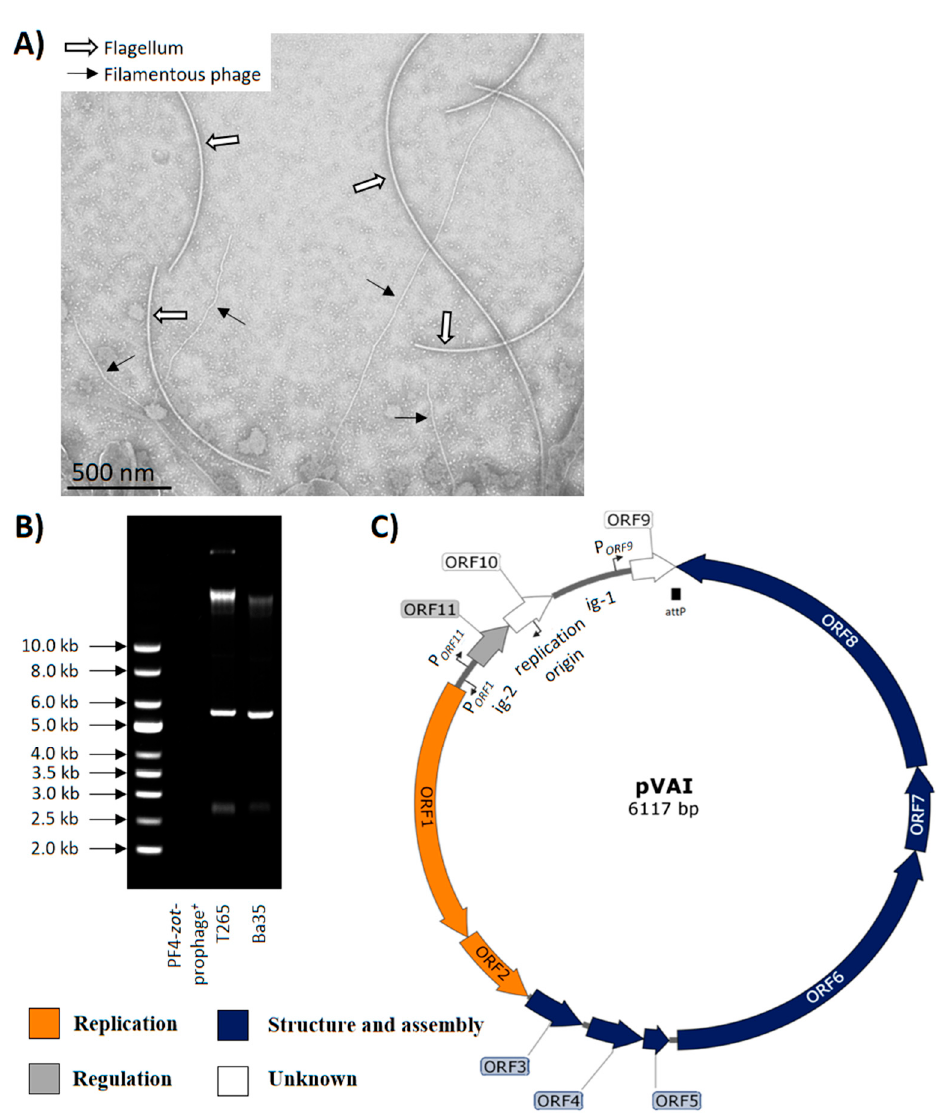
Figure 1. Electron micrograph of VAI ϕ particles and schematic representation of pVAIs. ( A ) Transmission electron micrographs of overnight cultures of Vibrio anguillarum strain Ba35. ( B ) Extraction of replicative forms in V. anguillarum strains separated on a 0.8% agarose gel. A supercoiled DNA ladder is shown to the left. ( C ) Schematic representation of pVAIs, the predicted attP , replication origin, promoters, intergenic regions and ORF organization. ORFs are represented by arrows oriented in the direction of transcription. The colors were assigned according to the possible role of each ORF as shown in the figure. The attP is indicated as a black rectangle and the replication origin and promoters are represented by bent arrows pointing in the direction of replication and transcription, respectively.